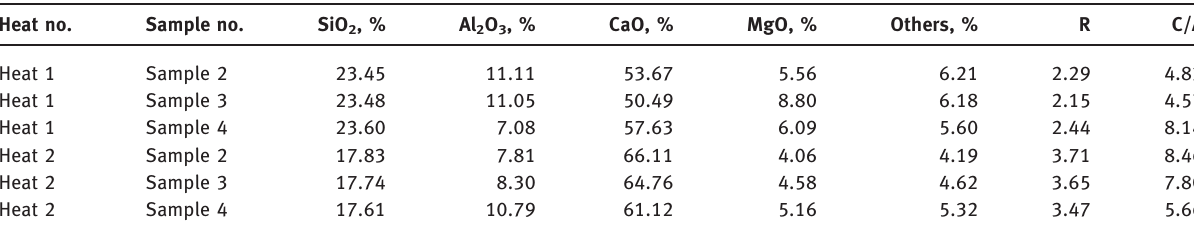
Table 3: Chemical composition of refining slag. Heat